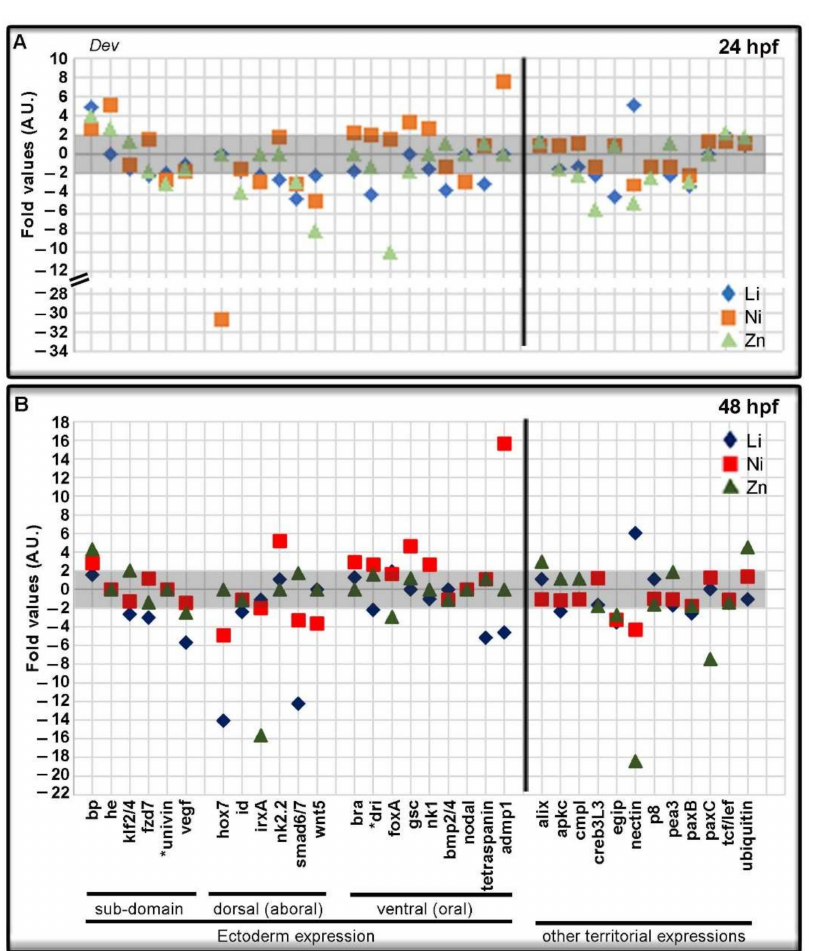
Figure 5. Development genes modulated by Li, Ni, and Zn treatments. The grey boxes indicate the threshold for insignificant changes following Li, Ni, and Zn treatments, i.e., fold values between − 2 and + 2 at 24 ( A ) and 48 ( B ) hours post-fertilization (hpf). Symbols in the plot at 24 hpf ( A ): light blue rhombus, Li-embryos; orange square, Ni-embryos; light green triangle, Zn-embryos. Symbols in the plot at 48 hpf ( B ): blue rhombus, Li-embryos; red square Ni-embryos; green triangle, Zn-embryos. Some Development genes were organized considering their dorsal and ventral ectoderm expression. Asterisks (*) indicate genes also expressed in other